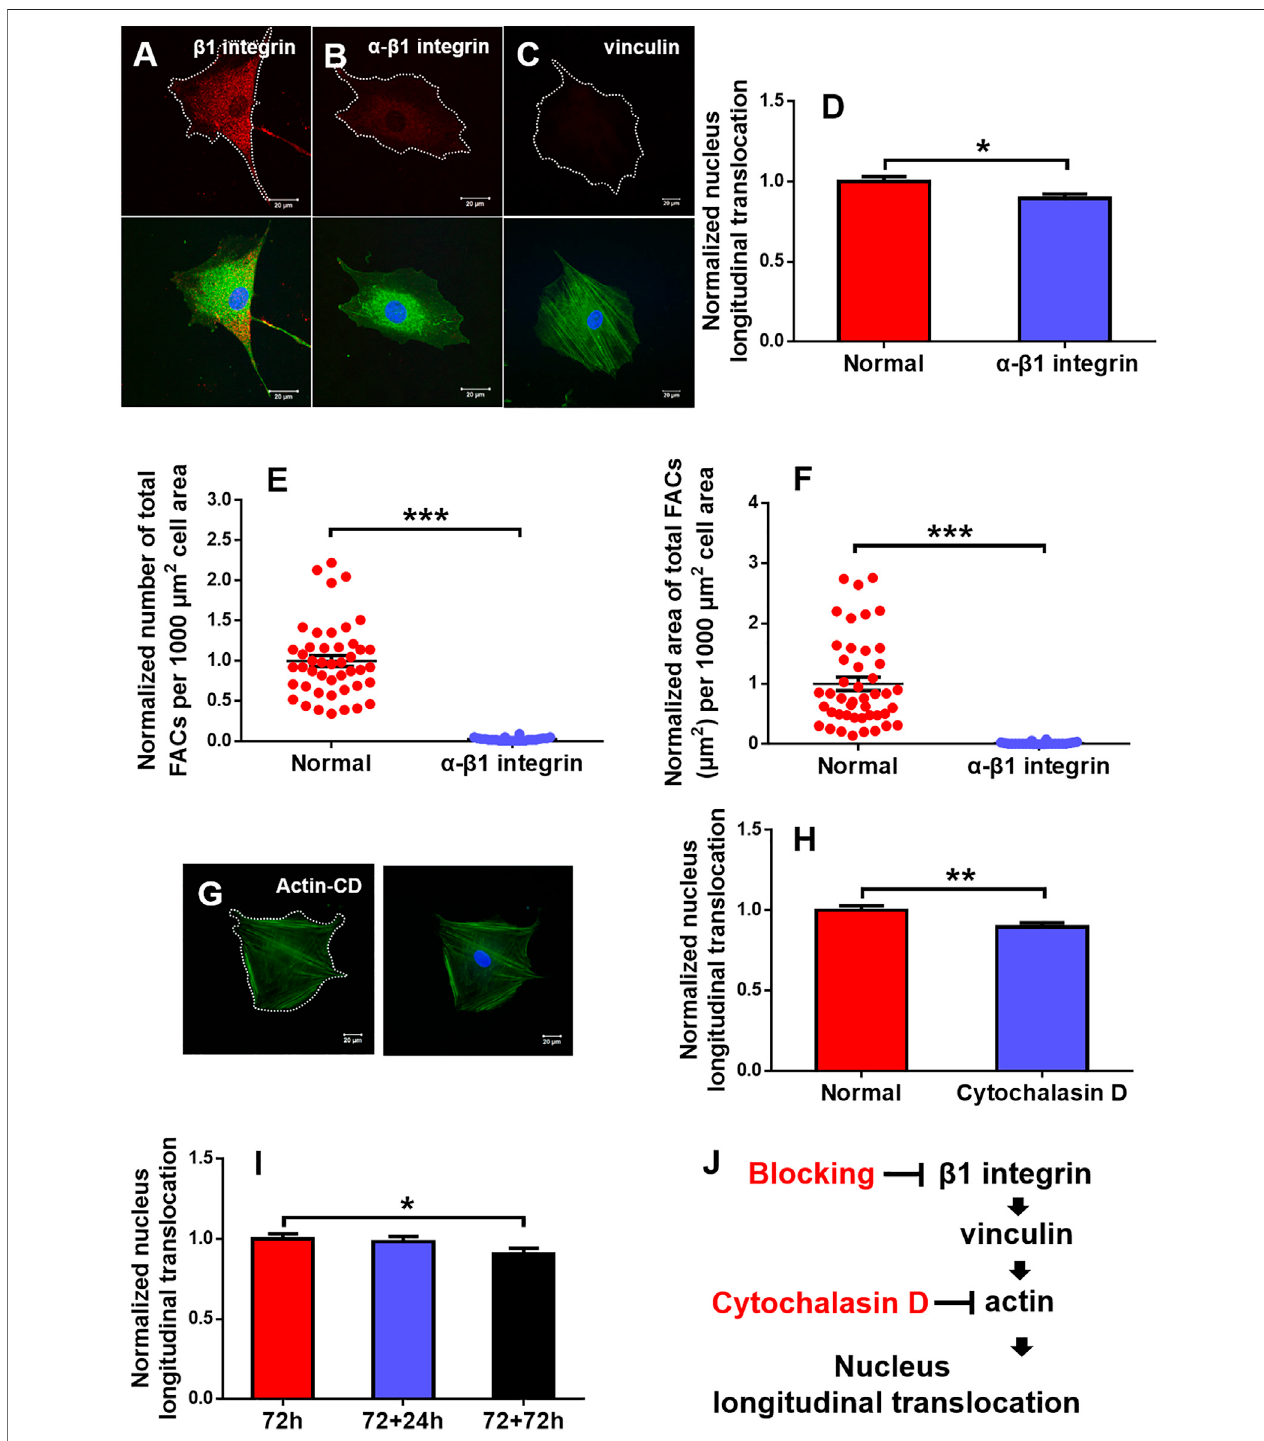
FIGURE7| Regulationofmechanotransductivepathways.Typicalimmuno fl uorescencestainingof β 1integrin (B) (red),vinculin (C) (red),andactin (G) (green;blue, cellnucleus)waspresentedat90 ° on2.5 MPapoly-dimethylsiloxane(PDMS)for72 hafter β 1integrinfunctionblockingwhentheonewithout β 1integrinblockingserved as control (A) or cytochalasin D disturbed F-actin (G) . Bar = 20 µm. The nucleus longitudinal translocation was normalized to control for β 1 integrin blocking (D) or cytochalasin D disturbed F-actin (H) at 90 ° on 2.5 MPa PDMS for 72 h. The number (E) and area (F) of total FACs were normalized to their respective controls. Nucleus longitudinal translocation for additional 24 and 72 h at 90 ° on 2.5 MPa PDMS was normalized to the one for 72 h (I) . *, **, or ***, t -test, p < 0.05, 0.01, or 0.001. Schematic of cellular mechanotransductive pathways. Inhibitors of key elements were depicted in red (J) . CD, cytochalasin D.